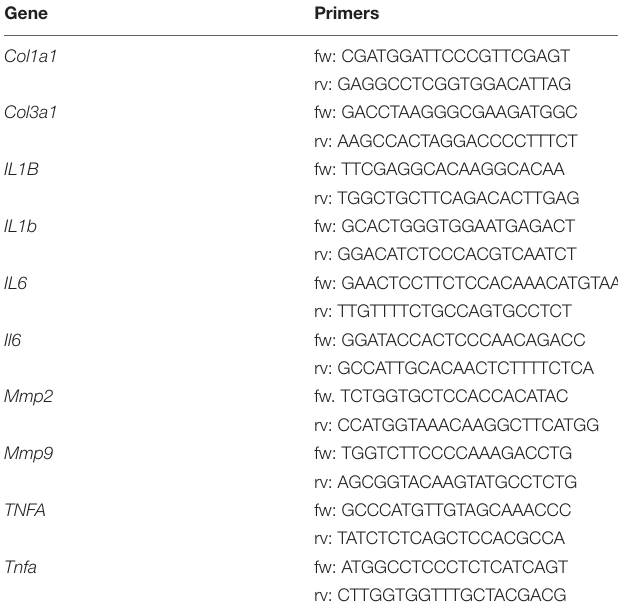
TABLE 1 | Primer sequences used for RT-qPCR